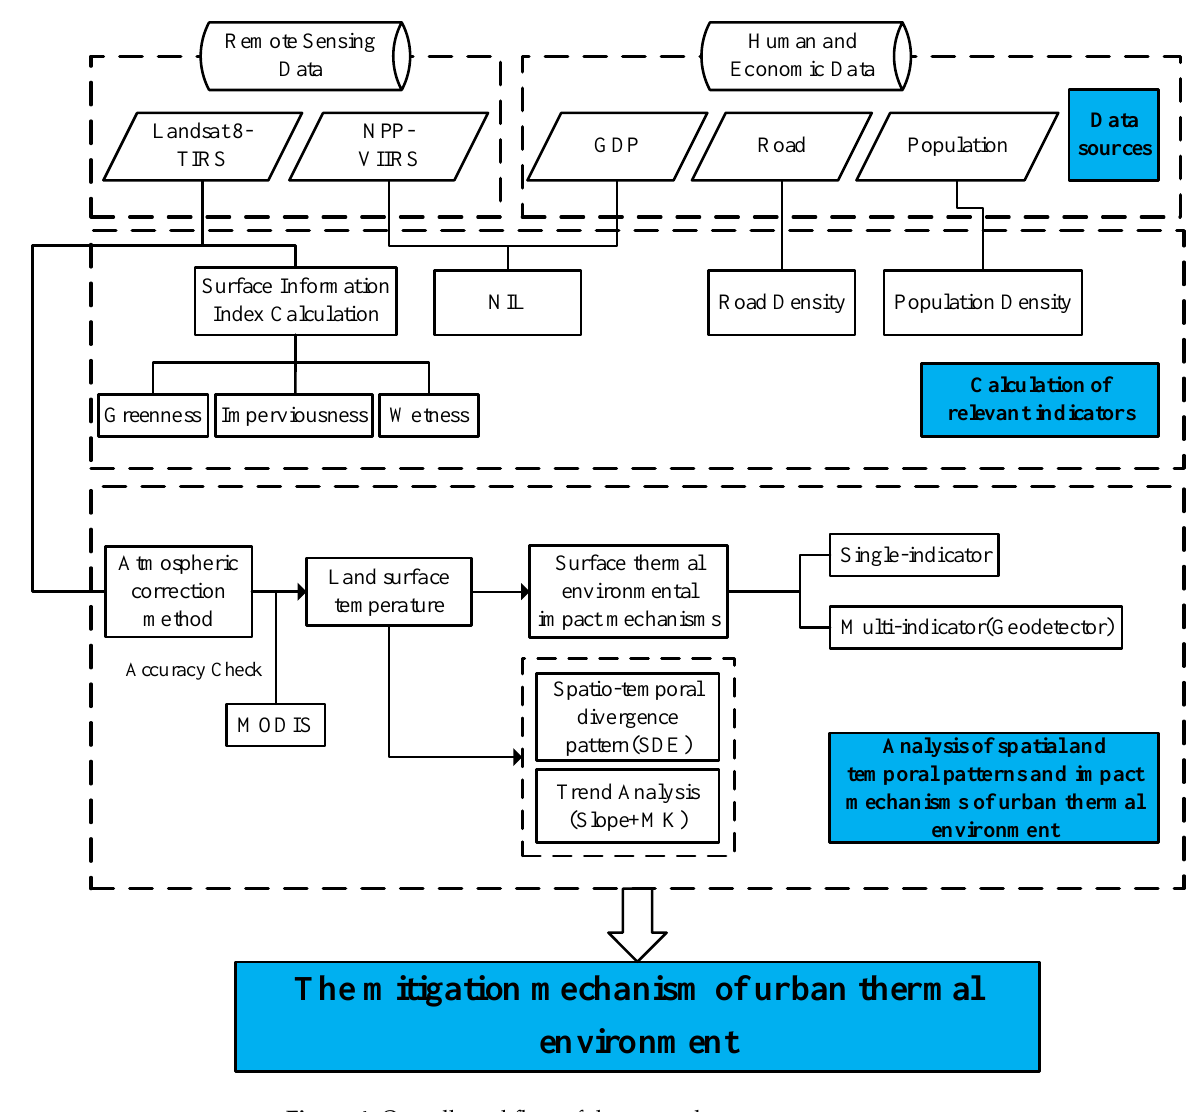
Figure 4. Overall workflow of the research.